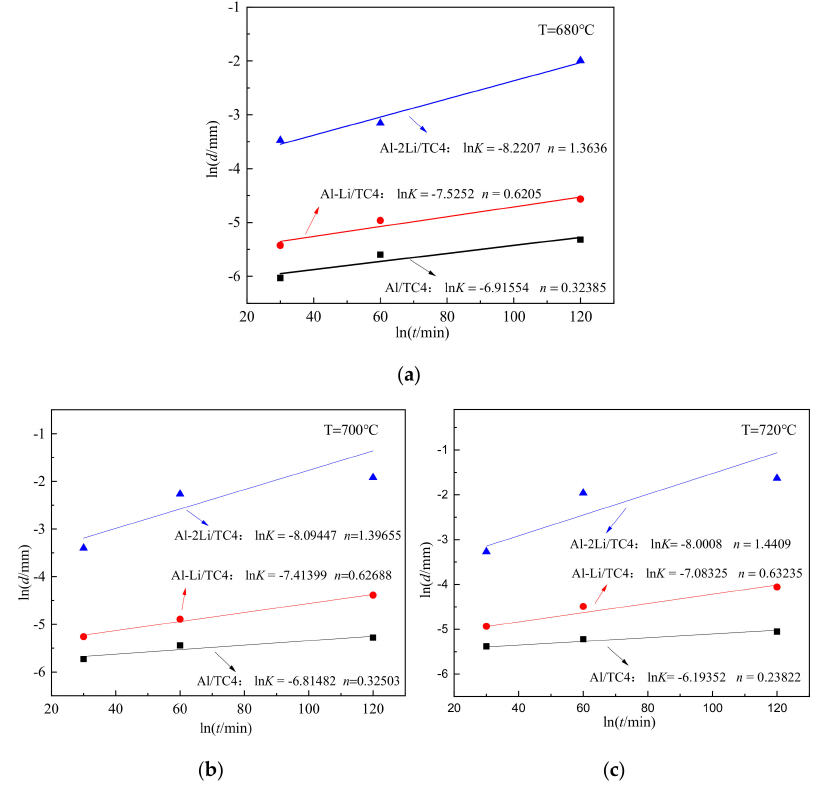
Figure 5. The relationship between the logarithm of DRL thickness and holding time; ( a ) 680 ◦ C; ( b ) 700 ◦ C; ( c ) 720 ◦